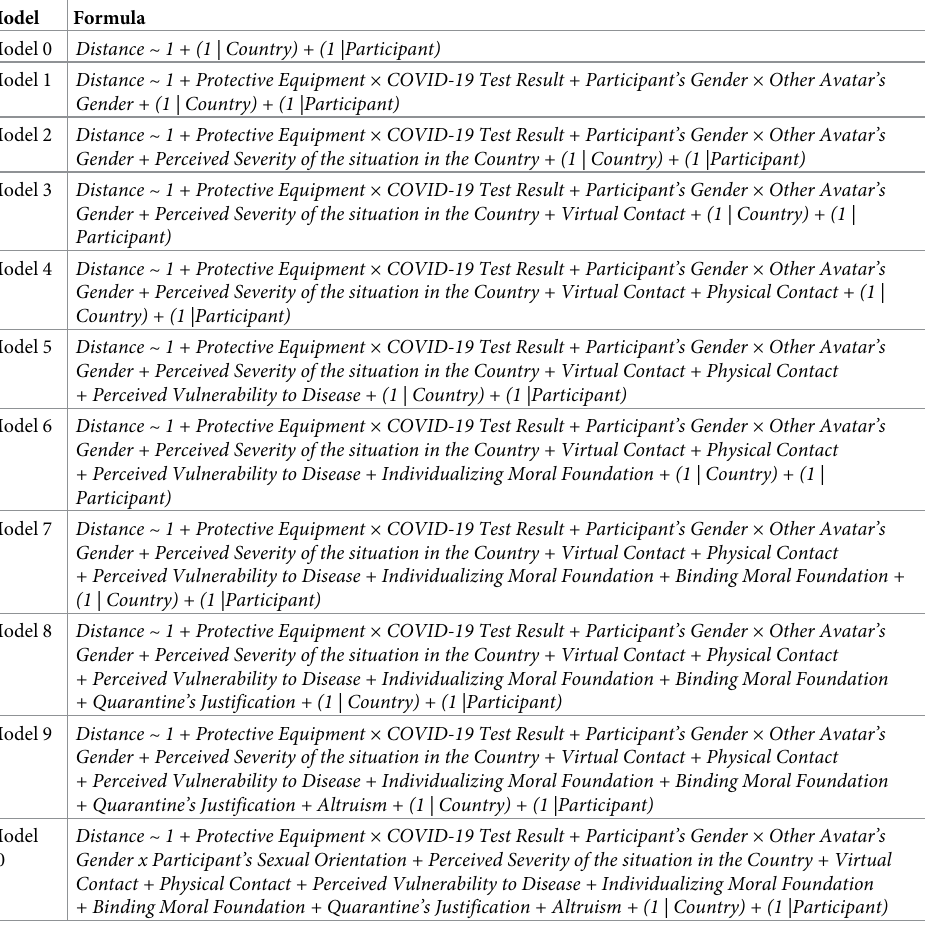
Table 2. Formulas for each